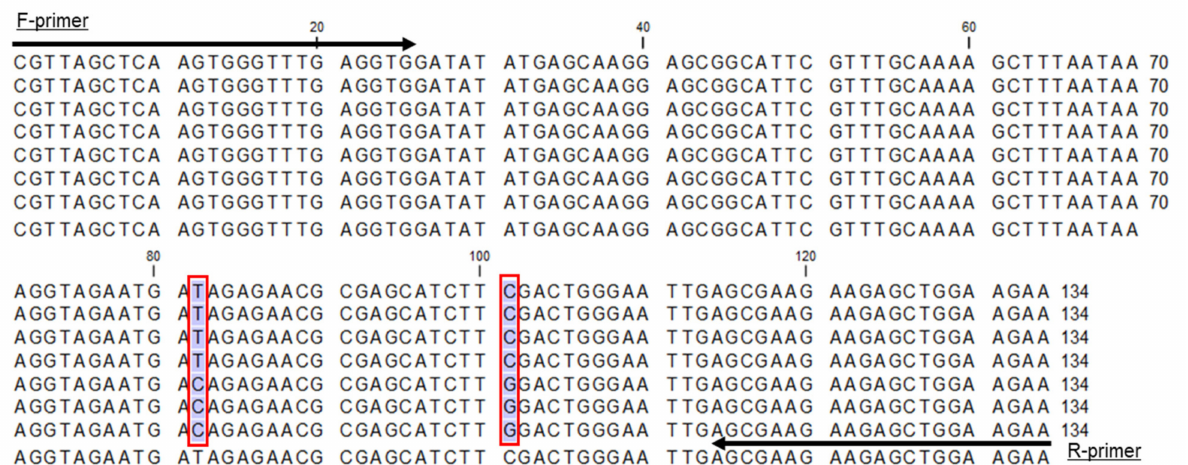
Figure 6. Sequences of the products amplified with the SNP-3 HRM primer in four resistant and three susceptible onion lines. Two SNPs were identified within the sequence. One SNP showed the ‘T’ allele in the resistant lines and the ‘C’ allele in the susceptible lines, while the other SNP showed the ‘C’ allele in the resistant lines and the ‘G’ allele in the susceptible ones. The forward (F) and reverse (R) primers for the SNP-3 HRM marker are underlined with the